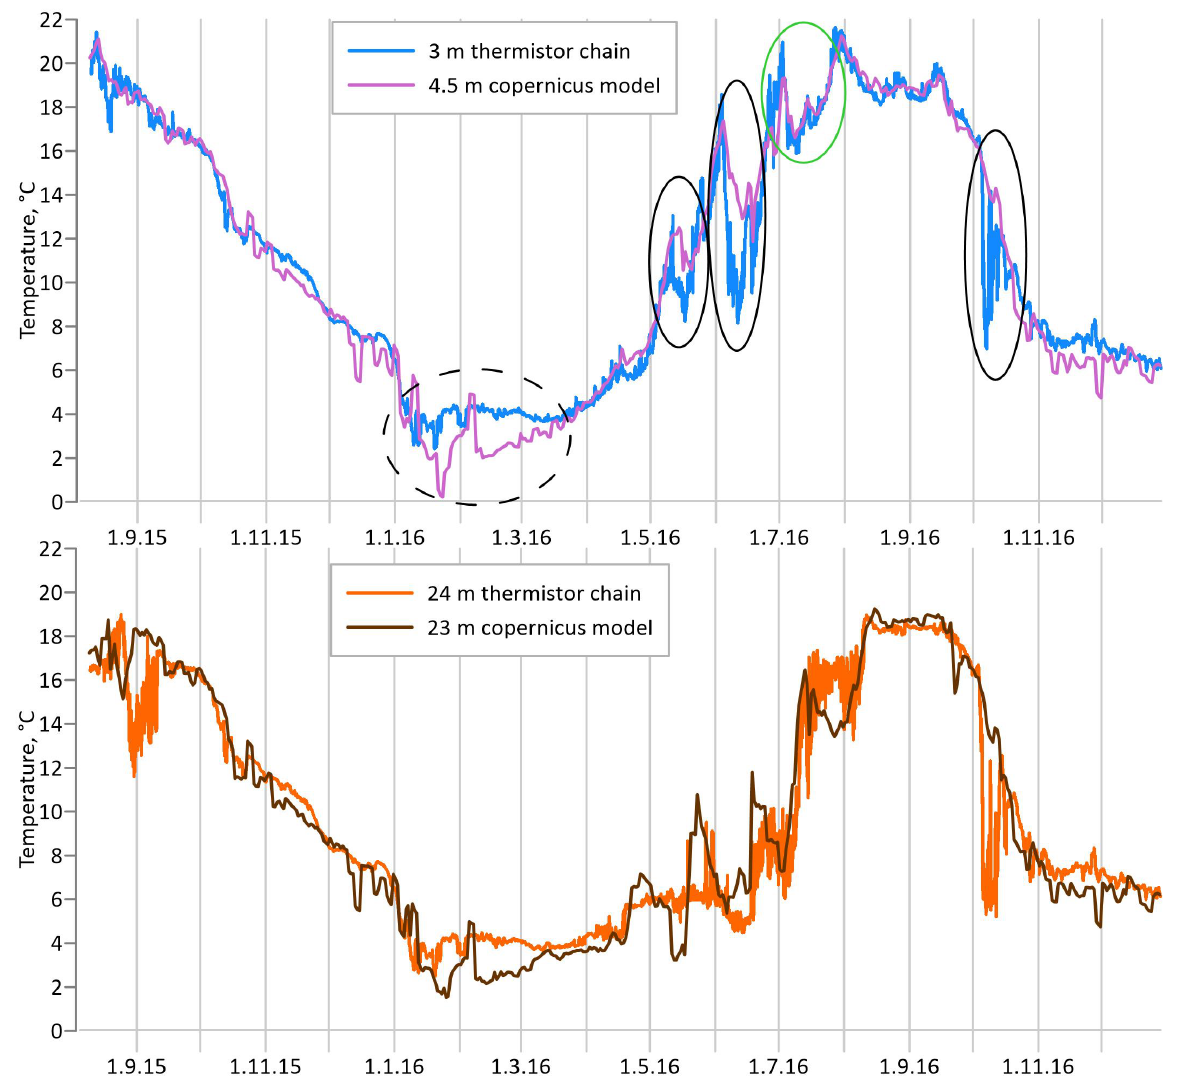
Figure 8. Water temperature near the surface and near the bottom according to the thermistor chain and Copernicus model data from 15.08.2015 to 31.12.2016. All solid circles mark upwelling events, and the green circle marks upwelling, as reproduced by the model. Dashed circle marks a winter period, when the model had great discrepancy with measurements.